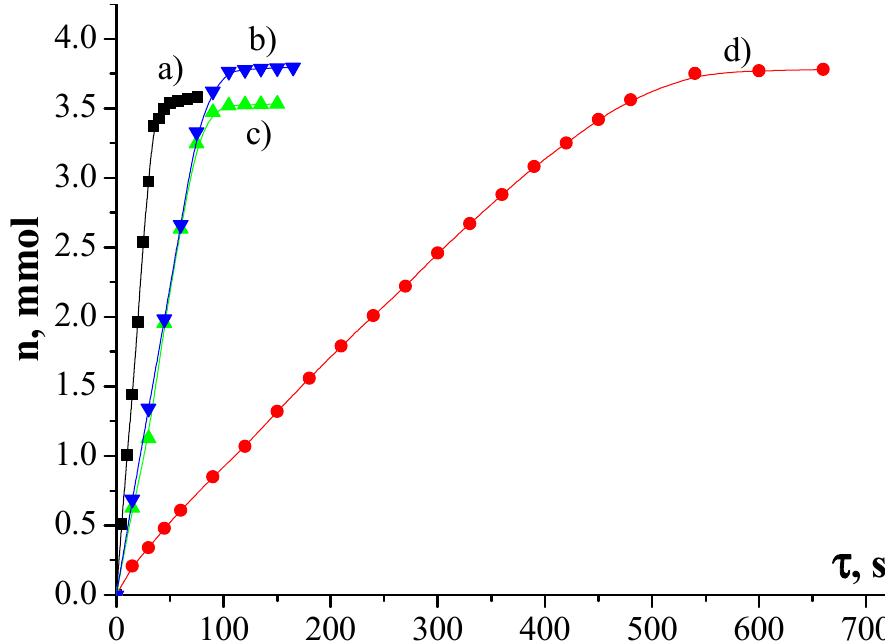
Figure 7. Kinetic curves of hydrogen uptake in the 4-nitroaniline hydrogenation in aqueous 2-propanol (0.68 mol fraction). T = 298K, m (cat) = 0.30 ± 0.05 g., m (NA) = 0.50 ± 0.05 g. ( a ) 5 wt.% Pd/SiO 2 -C 3 H 6 -(30%)NH 2 ; ( b ) 5 wt.% Pd/C; ( c ) 5 wt.% Pd/ γ -Al 2 O 3 ; ( d ) 5 wt.% Pd/SiO 2 . Table 4. Catalytic recyclability test for a successive five cycles of 4-nitroaniline hydrogenation. The Hydrogen Consumption Rate 10 − 5 Mole(H 2 ) / Catalyst